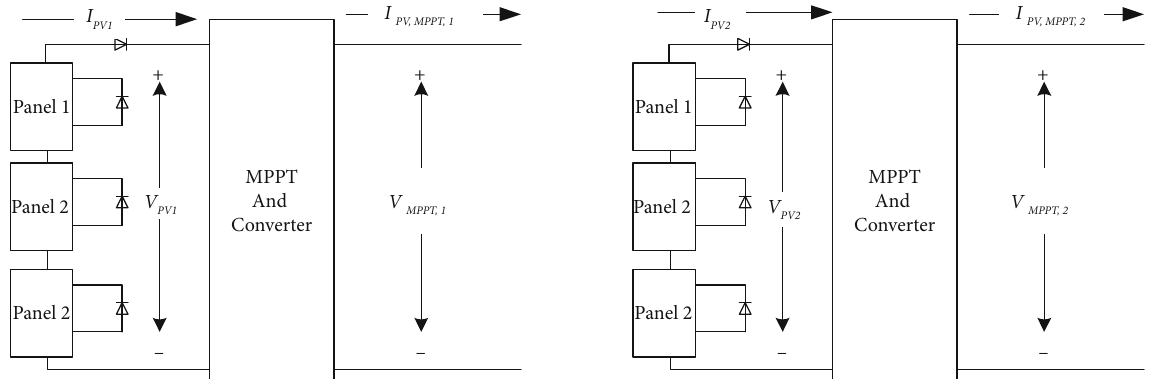
Figure 6: Domestic solar system con fi guration of this article.